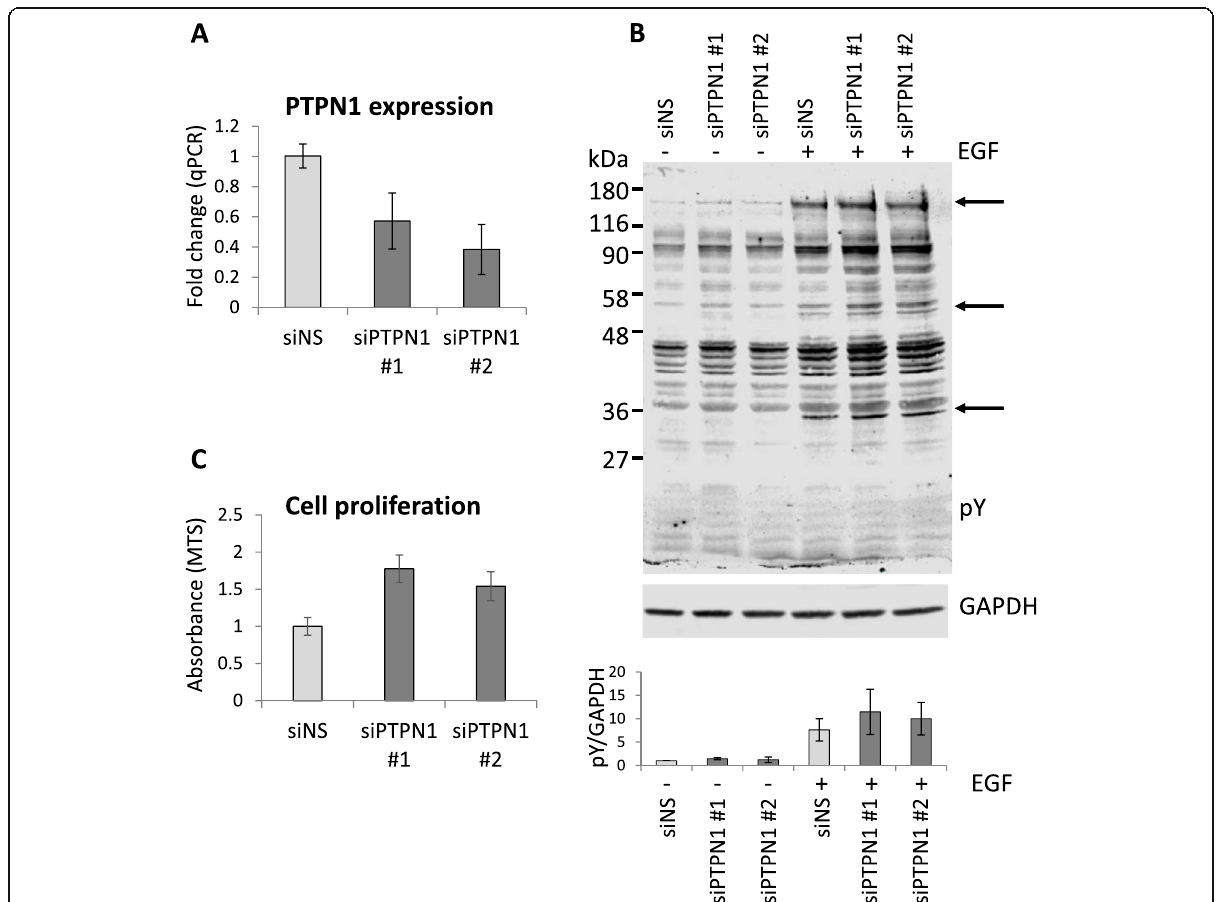
Fig. 1 Tyrosine (Tyr) phosphorylation and proliferation of SH-SY5Y cells upon PTPN1 siRNA knock-down. Cells were transfected with control (siNS, non-specific) siRNAs or with two different siRNAs targeting PTPN1 (siPTPN1 #1, siPTPN1 #2), and assays were performed 72 h after transfection. a The silencing efficiency of the distinct siRNAs is shown, as monitored by RT-qPCR using specific primers. b Phosphotyrosine cell content was analysed by immunoblot with anti-phosphotyrosine 4G10 mAb (pY). GAPDH immunoblot was run as loading control. In the upper panel, a representative experiment is shown. In the lower panel, the quantification of phosphotyrosine content from each condition is shown. Results are shown as phosphotyrosine content normalized to GAPDH content (pY/GAPDH). c MTS cell proliferation; AU, arbitrary units. Data are shown as the mean + SD from two technical replicates from a representative experiment ( a and c ) or as the mean + SD from two independent experiments ( b